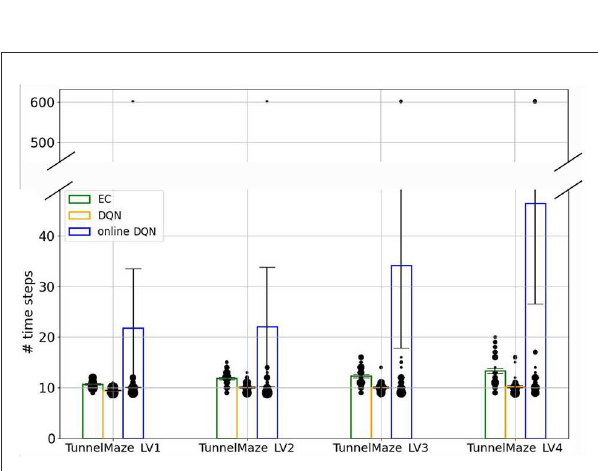
do not—with sparse sampling, the learning speed got improved